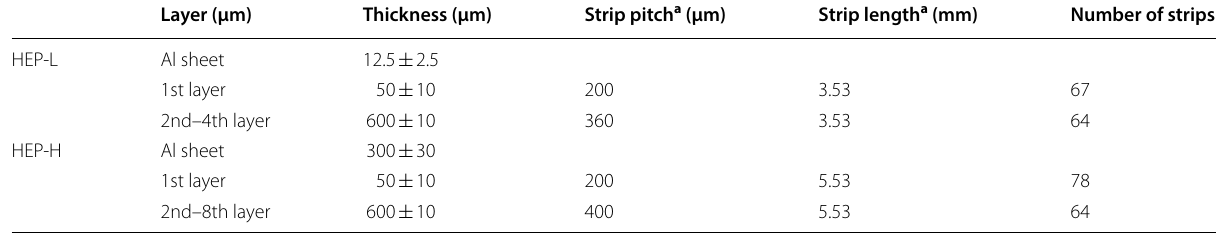
a The manufacturing errors for the strip pitch and the strip length are less than